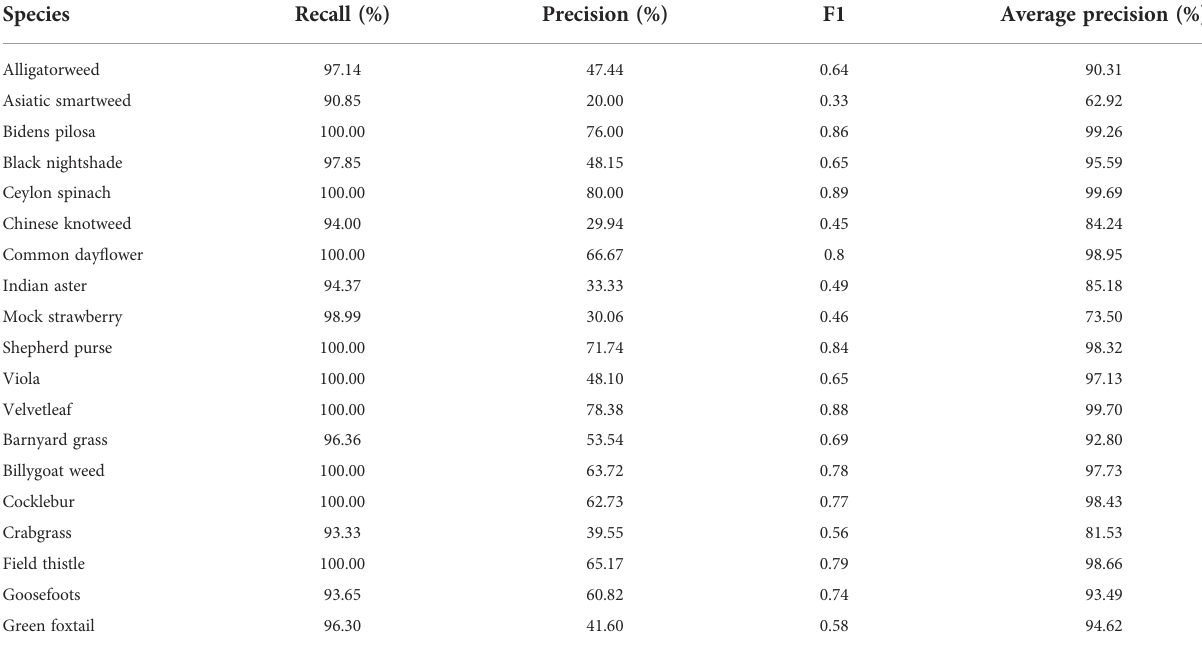
TABLE 5 Training results of Faster R-CNN (precision represents the ratio between the number of correctly detected weeds and predicted weeds of a certain type). Species Recall (%) Precision (%) F1 Average precision